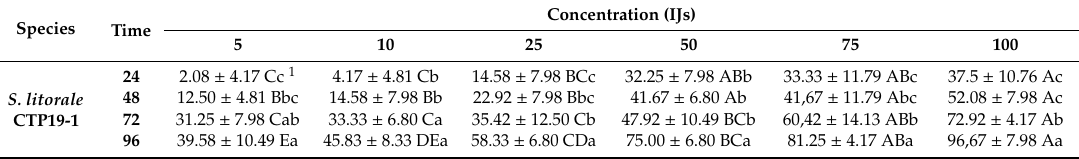
Figure 3. Percentage of mortality of G. mellonella larvae with different doses of S. litorale CTP19-1. Table 3. Mortality rates (%) of G. mellonella treated with S. litorale CTP19-1.